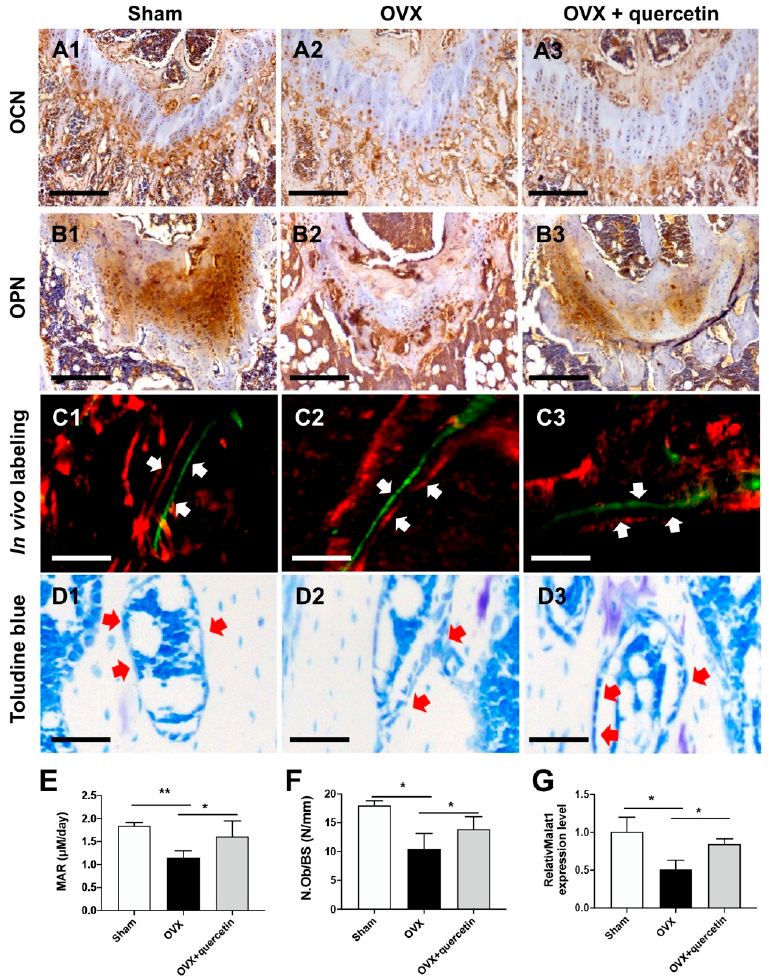
Figure 8. Histomorphometry of the distal femur from OVX mice upon quercetin treatment. ( A , B ) Representative images of femoral metaphysis with IHC staining using osteocalcin (OCN) ( A ) and osteopontin (OPN) ( B ) antibodies. Scale bar: 200 µM. ( C , D ) In vivo double labels ( C ) and Toluidine blue staining ( D ) of the distal femur sections. Red arrow: osteoblast. Scale bar: 100 µM. ( E , F ) Histomorphometric analysis of distal femur sections, including mineral apposition rate (MAR) ( E ) and number of osteoblasts per bone surface (N.Ob/BS) ( F ). ( G ) Serum level of Malat1 was revealed in OVX mice upon quercetin treatment. Data are shown as mean ± SD ( n = 6; * p < 0.05, ** p < 0.01).